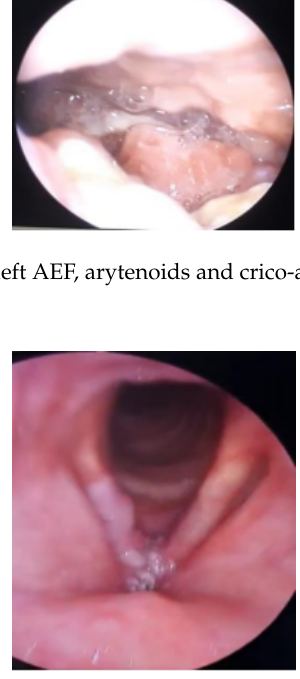
Figure 8. Keratotic lesion over anterior commissure involving right vocal cords